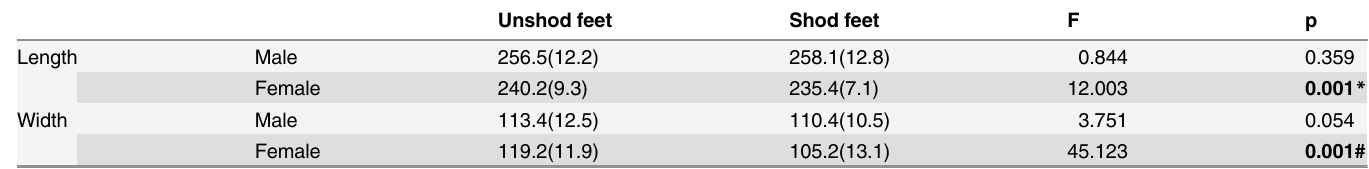
Table 4. The one-way ANOVA of length and width of unshod and shod feet (mm).